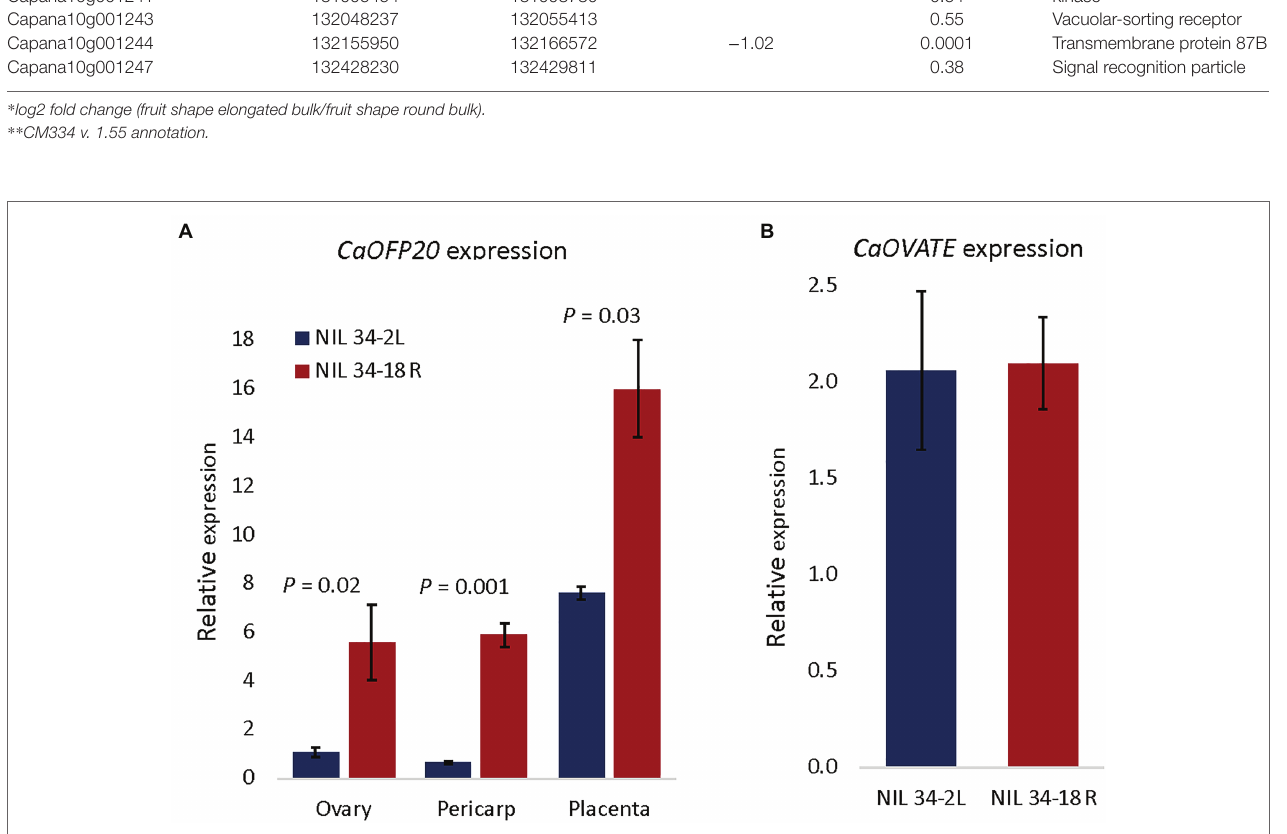
FIGURE 4 | Expression of CaOFP20 is downregulated in the elongated fruit fs10- NIL 34-2L, whereas no difference was observed for CaOVATE . (A) Expression of CaOFP20 in ovary at anthesis and in pericarp and placenta of the fruit 3 weeks after anthesis. (B) Expression of CaOVATE in ovary at anthesis. Significant differences between the NILs were determined by Student’s t